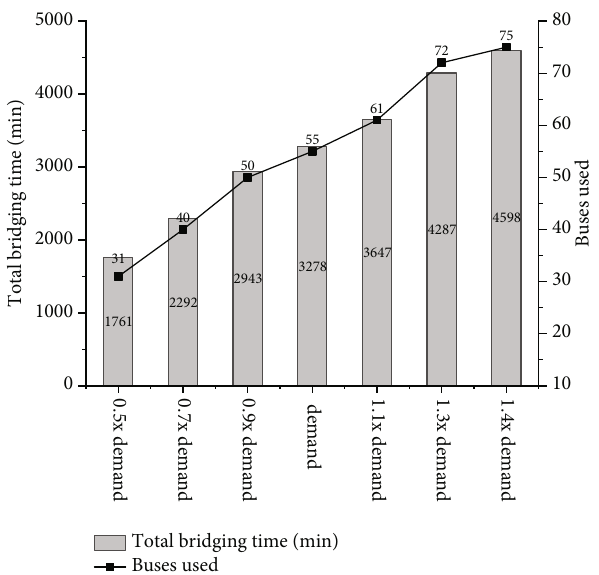
Figure 8: Changes in total bridging time and buses used under di ff erent passenger